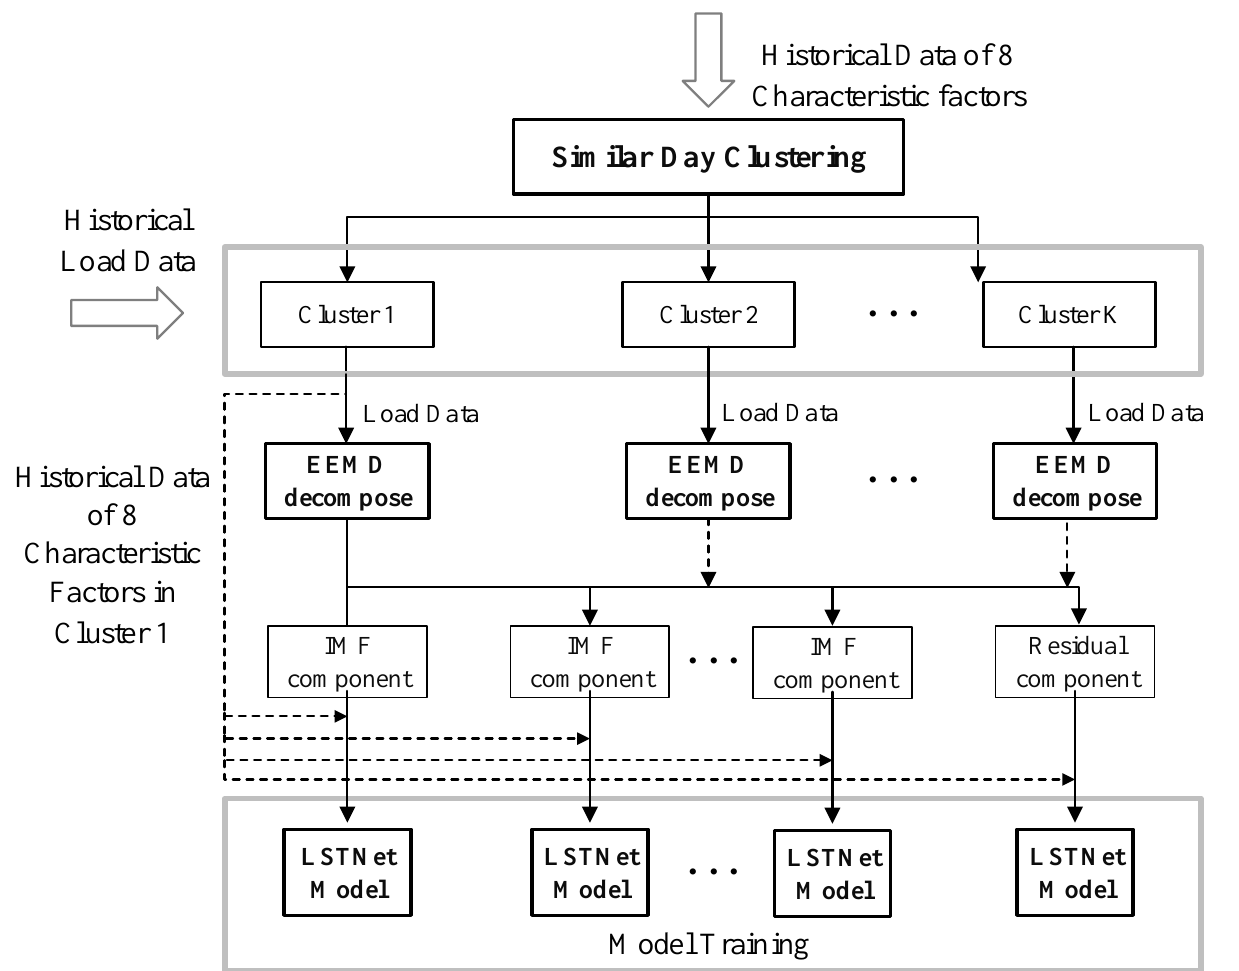
Figure 3. The process of the proposed load forecasting